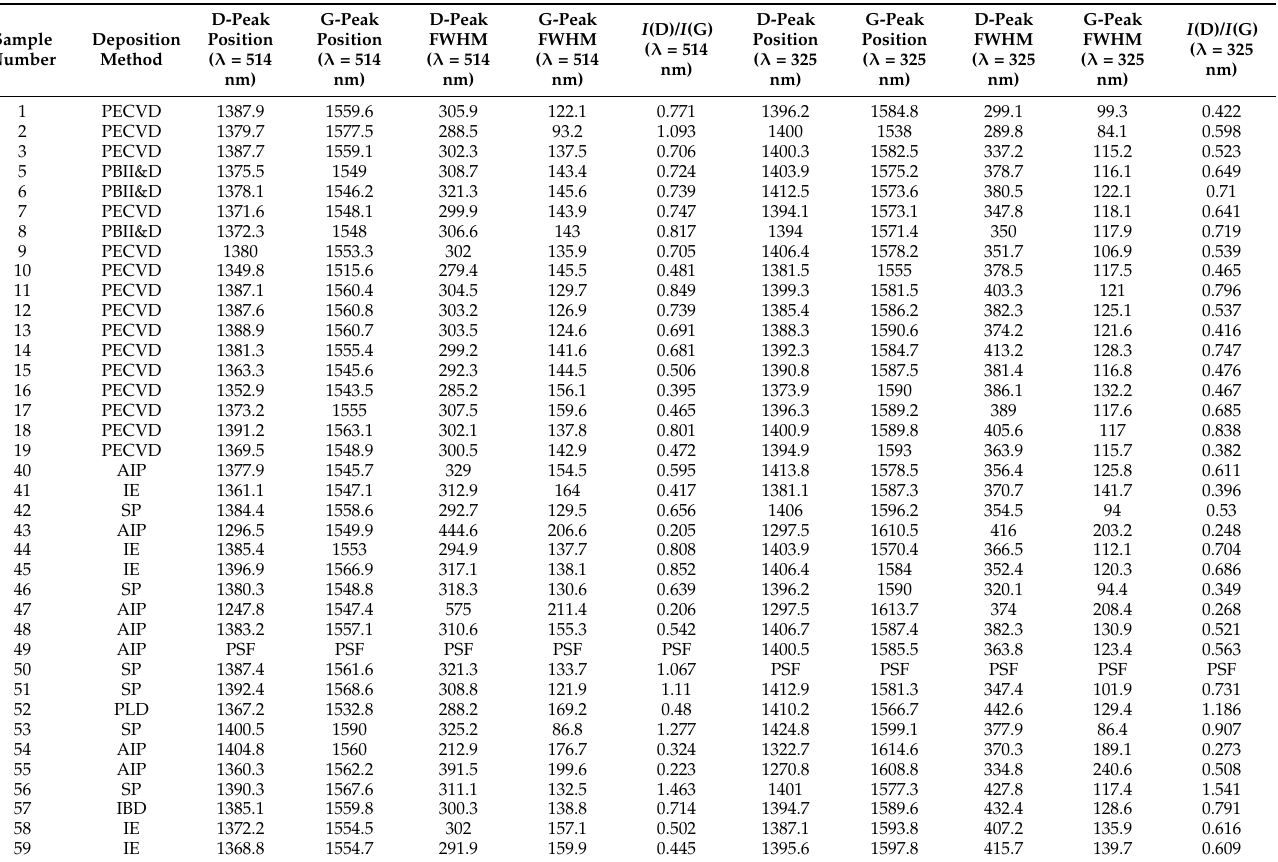
Table 3. Results of the VIS and UV Raman spectroscopic analyses of 39 amorphous carbon films. The sample number in this table is the same as that in Table